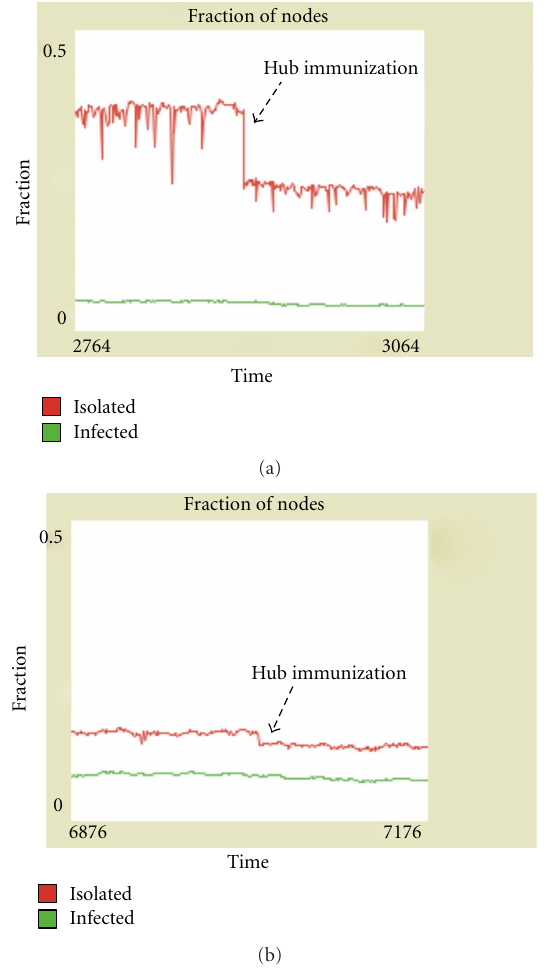
Figure 3: Instantaneous fractions of isolated nodes (red line) and infected nodes (green line) in diverse (a) DH network and (b) random BA network. The vertical drop in each instantaneous fraction of isolated nodes is due to immunization of the largest hub